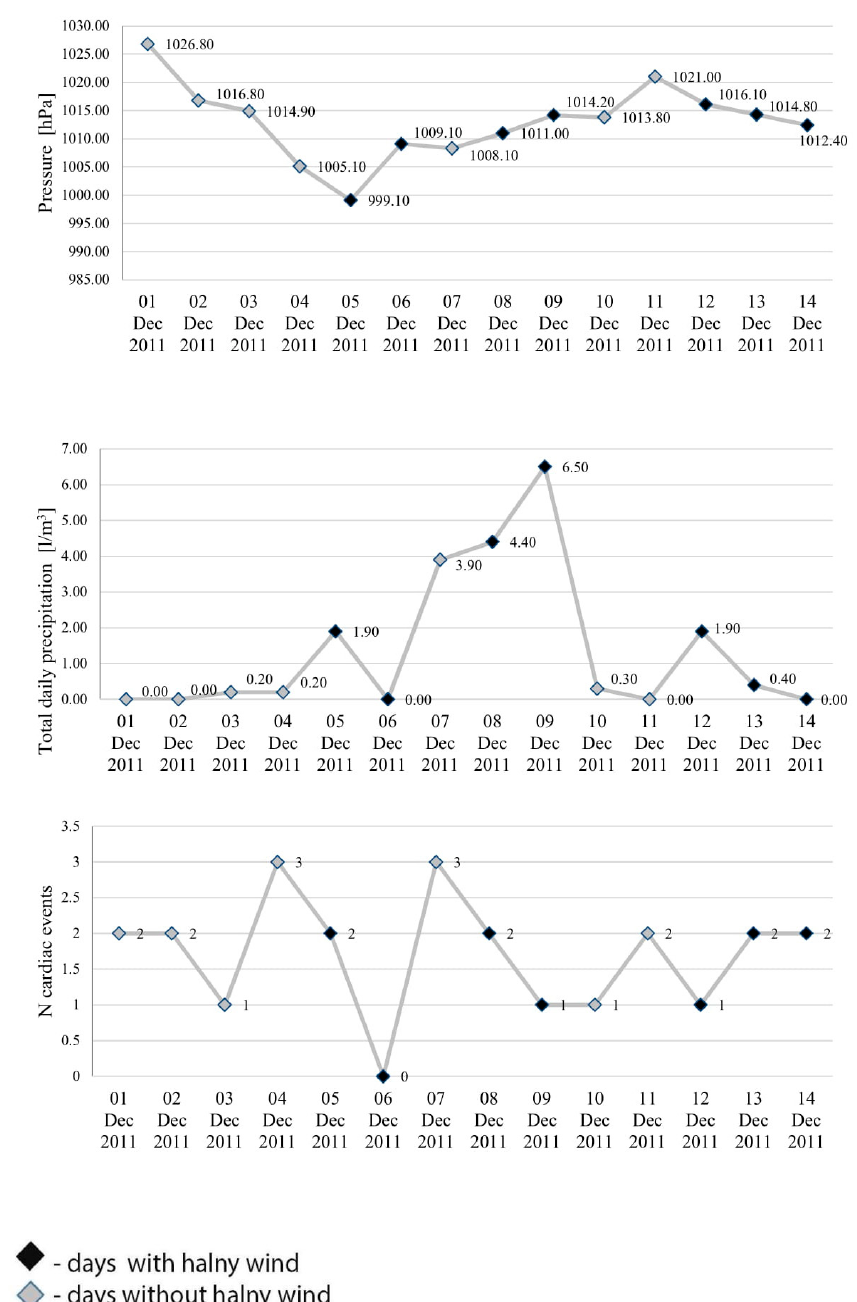
Figure 2. Changes in mean pressure, total daily precipitation and number of cardiac events for the period from 1 to 14 December 2011. period from 1 to 14 December